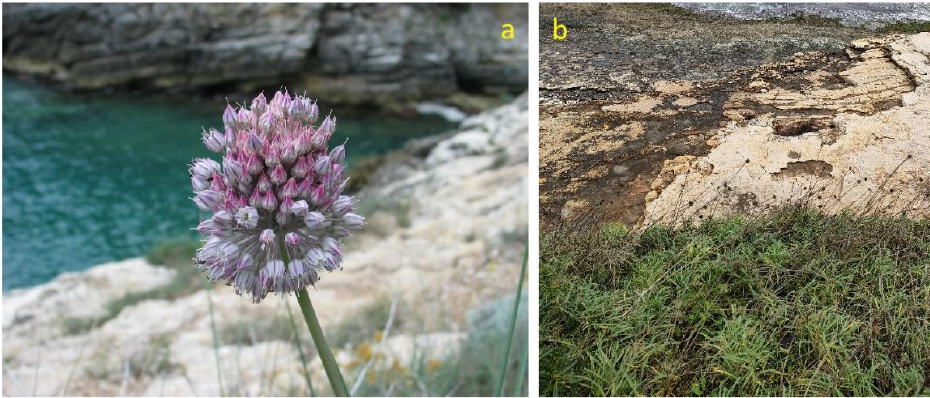
Figure 13. Allium commutatum inflorescence ( a ); A. commutatum community in the winter season ( b.